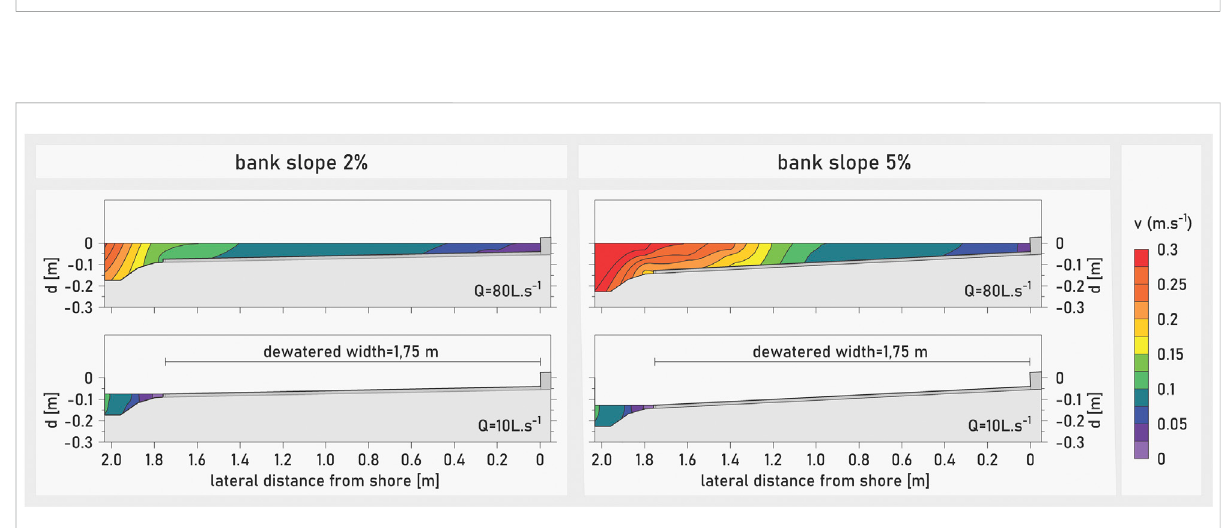
FIGURE 2 Cross-sectional plot of fl ow velocity distribution in the mesocosms at high fl ow rate of 80 L s − 1 (top) and low fl ow rate at 10 L s − 1 (bottom) for the 2% (left) and 5% bank slope (right) setups.